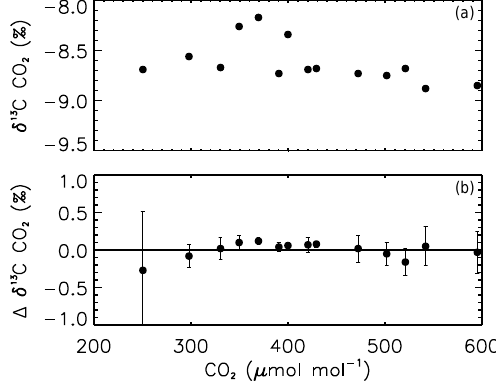
Figure 5. Secondary standards used to calibrate the laser spectro- scopic system have δ 13 C and δ 18 O values from direct measurement by INSTAAR, and they have measured δ 13 C and δ 18 O from calibra- tion on the laser spectroscopic system against the primary CO 2 stan- dards. (a) shows the INSTAAR δ 13 C values as a function of CO 2 . Uncertainties on the INSTAAR values (less than 0.02‰) are not visible. (b) shows the difference between the NOAA and INSTAAR measurements of the secondary standards (NOAA–INSTAAR) also as a function of CO 2 . Error bars are the standard deviation of four calibration episodes of the secondary standards vs. the primary stan- dards on the NOAA CO 2 calibration system.